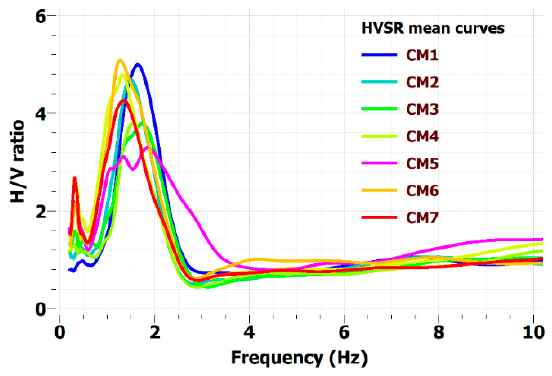
Figure 22. Summary of the mean spectral ratio curves obtained at the seven sites.